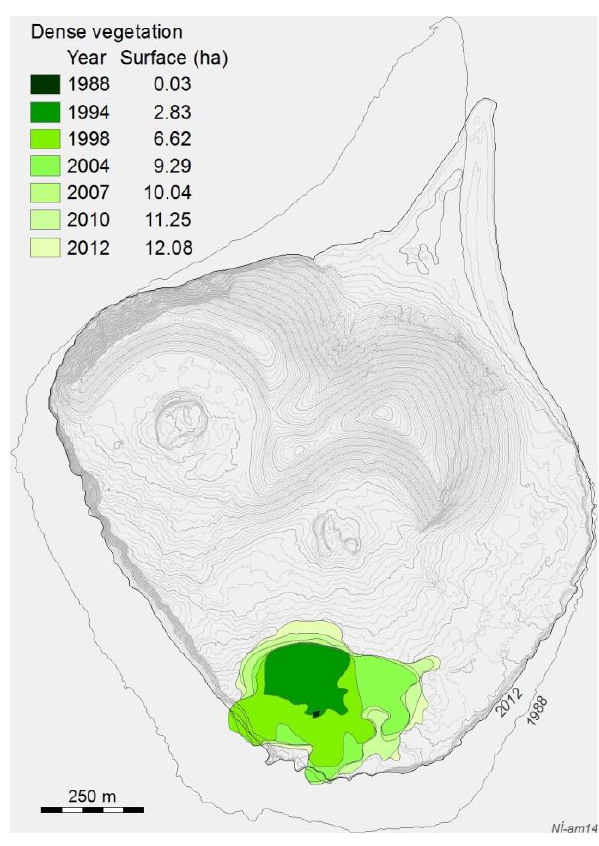
Figure 6. Expansion of dense vegetation within the Surtsey seagull colony during the period 1988–2012. Approximation from aerial and sattelite images, by Anette Th. Meier. Island outlines indicate erosion over the